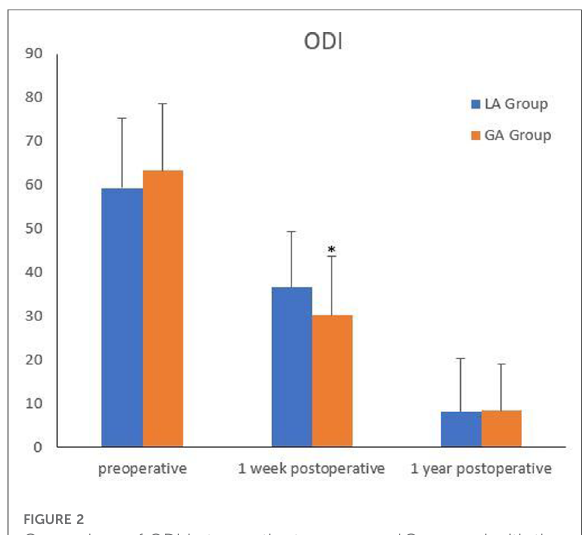
FIGURE 2 Comparison of ODI between the two groups. *Compared with the LA group at one week postoperatively, P